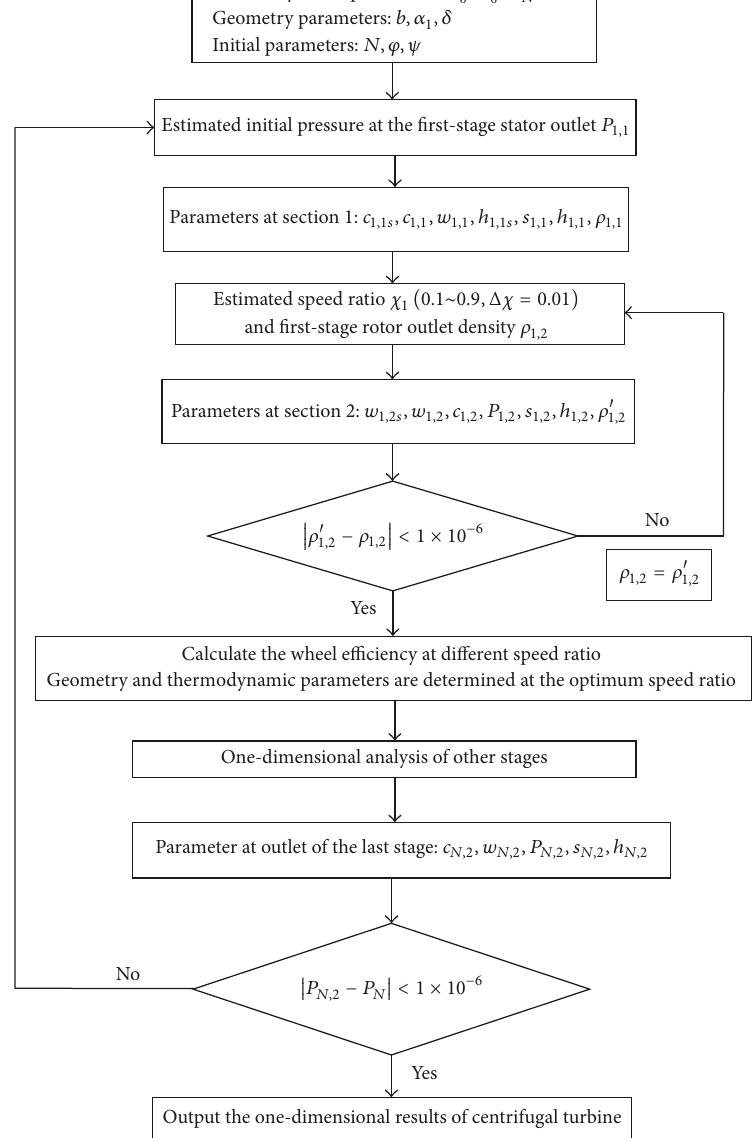
Figure 1: One-dimensional design process of centrifugal